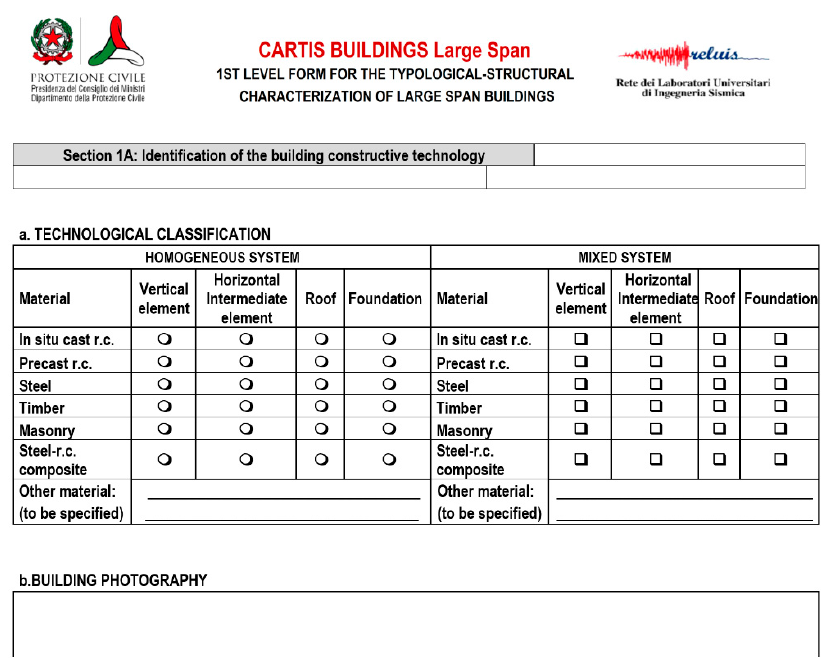
Figure 9. Section 1A CARTIS-Building: Identification of the building constructive technology (English version [19]).